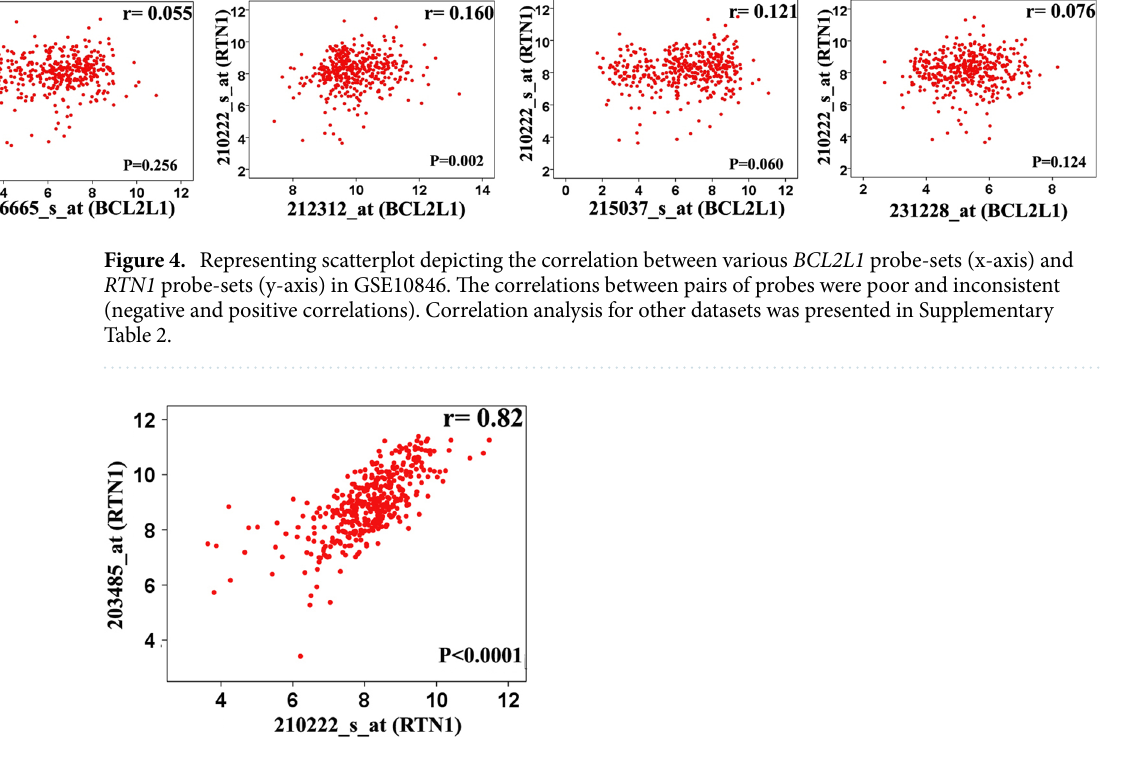
Figure 5. Representative scatterplot depicting the correlation between two RTN1 probe-sets (203485_at and 210222_s_at). Correlation coefficient between two probe-sets was statistically significant (r = 0.82) ( P <